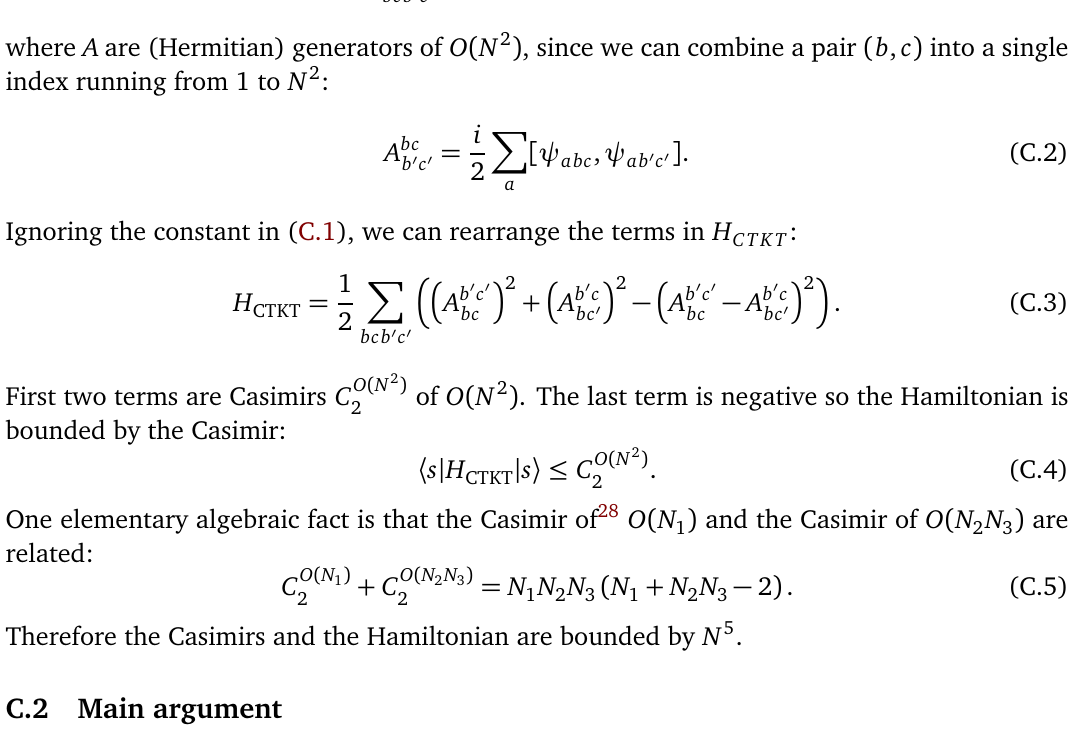
part. (c) The resulting